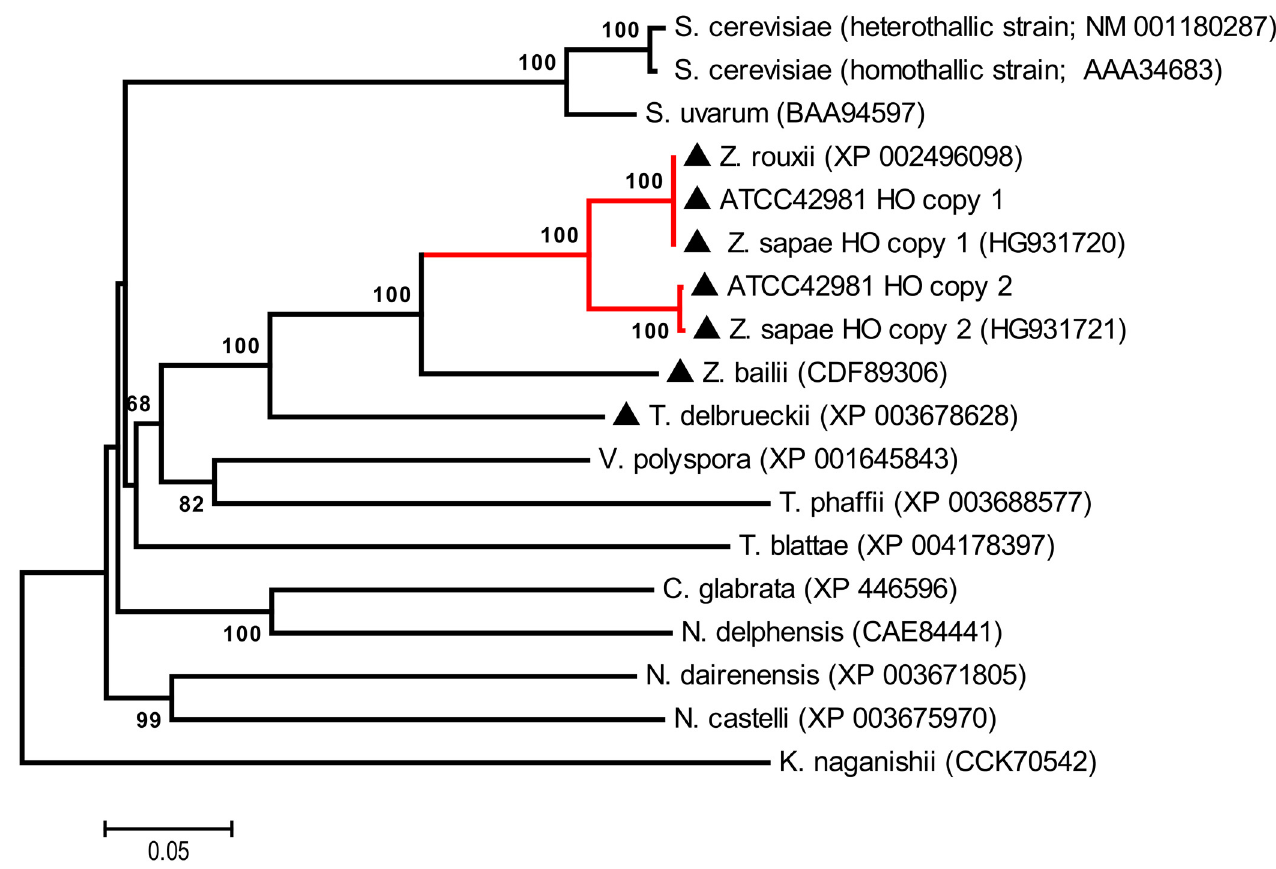
Fig 5. Phylogenetic analysis of HO endonucleases. Neighbor-joining (NJ) tree shows evolutionary relationships between ATCC 42981 strain and other hemiascomycetes as inferred from HO proteins. Numbers on branches indicate bootstrap support (1,000 pseudoreplicates) from NJ. The red branch indicates Z . rouxii complex, which includes ZrHO, ZsHOs and ATCC 42981 HO sequences, whereas the dark triangle designates pre-WGD